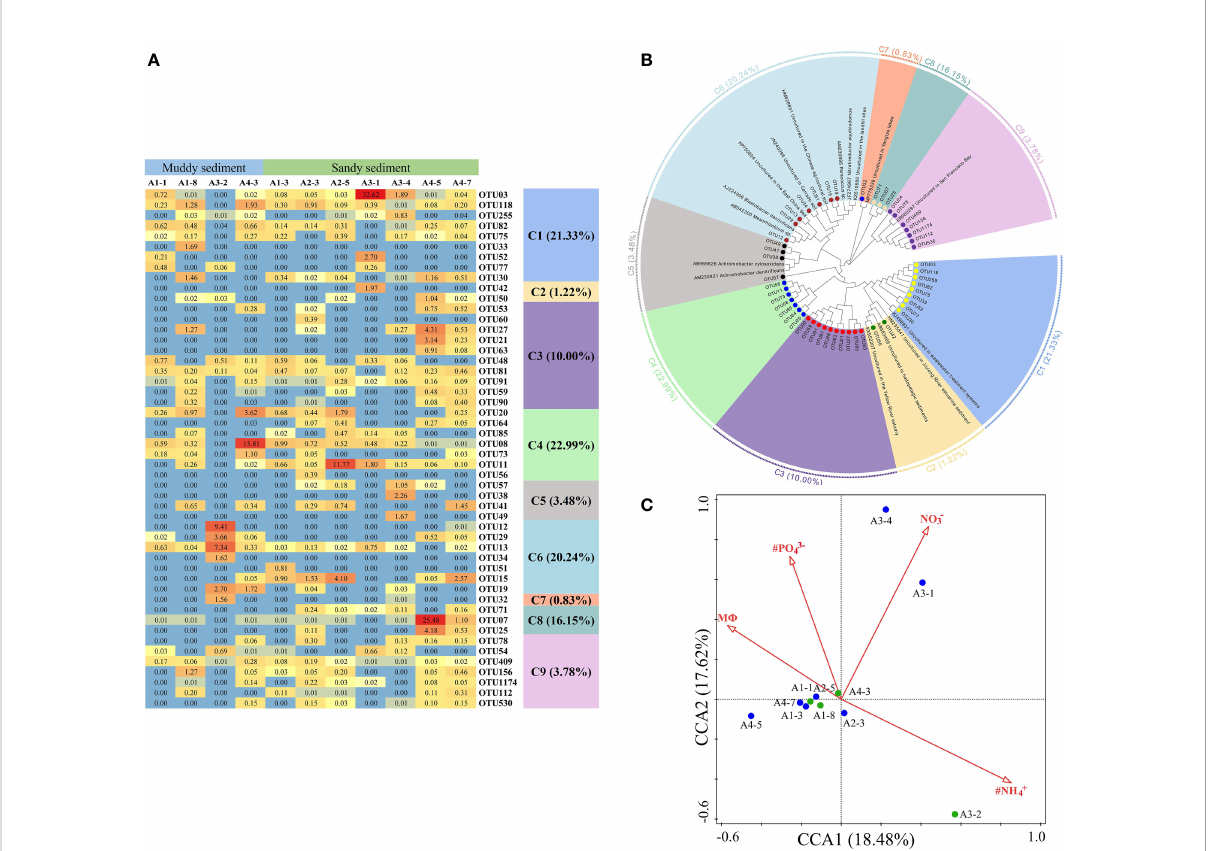
FIGURE 7 (A) The heat map of the dominant denitri fi cation OTUs for the nir K gene (top 50 OTUs, 97% cutoff). (B) Reconstructed phylogenetic tree with neighbor-joining method of nir K-gene sequences (bootstrap 1000). (C) The canonical correspondence analysis (CCA) for environmental factors and the nir K gene-encoded denitrifying